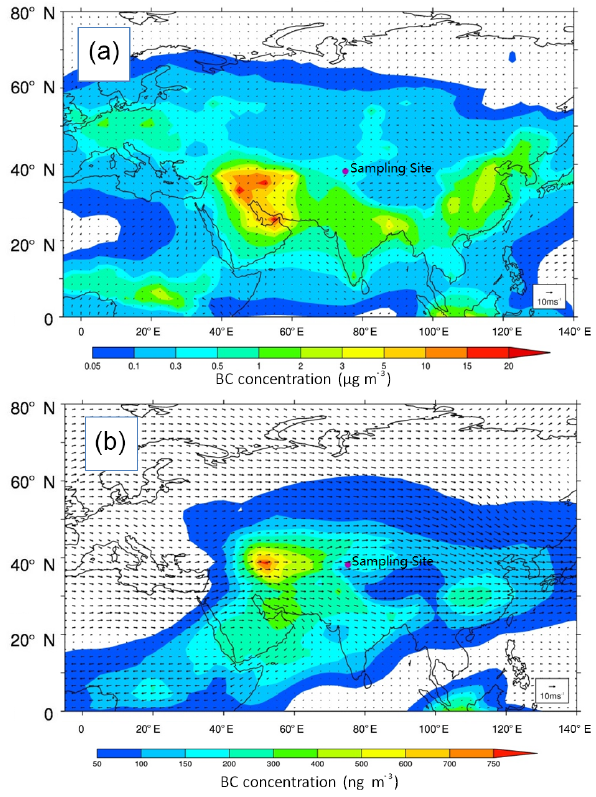
Figure 6. The calculated horizontal distributions of BC concentra- tions (µgm − 3 ) at the surface (a) and the concentrations (ngm − 3 ) at 5km above the surface (b) in Kuwait during 1991. The wind direc- tion and speed are indicated by black